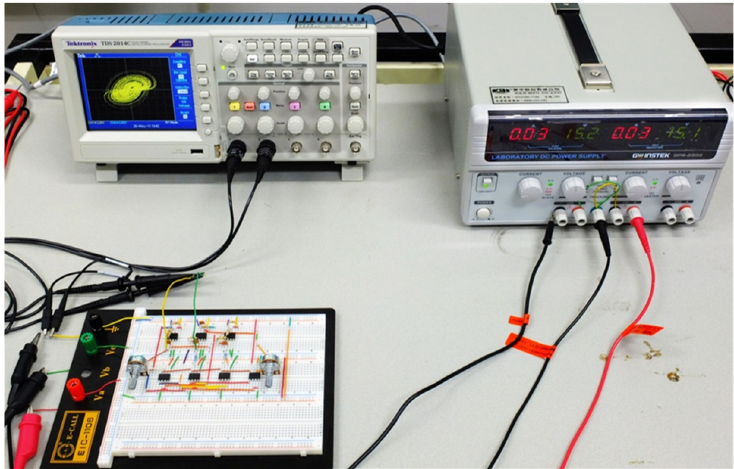
Figure 5. Experimental setup for realization of the four-dimensional Chen–Lee system.